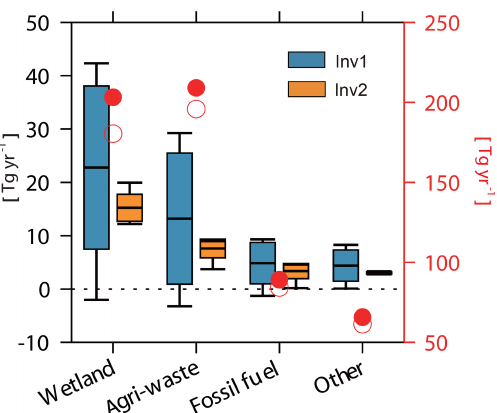
Figure 4. Global total CH 4 emissions from four broad categories from July 2000–June 2002 (Tgyr − 1 ). The red circles and dots show the prior emissions and mean optimized emissions, respec- tively, as calculated by Inv1 (right axes), and the box plots (defined in Fig. 1) show the difference between prior emissions (optimized minus prior, left axes) and optimized emissions calculated by Inv1 (blue) and Inv2